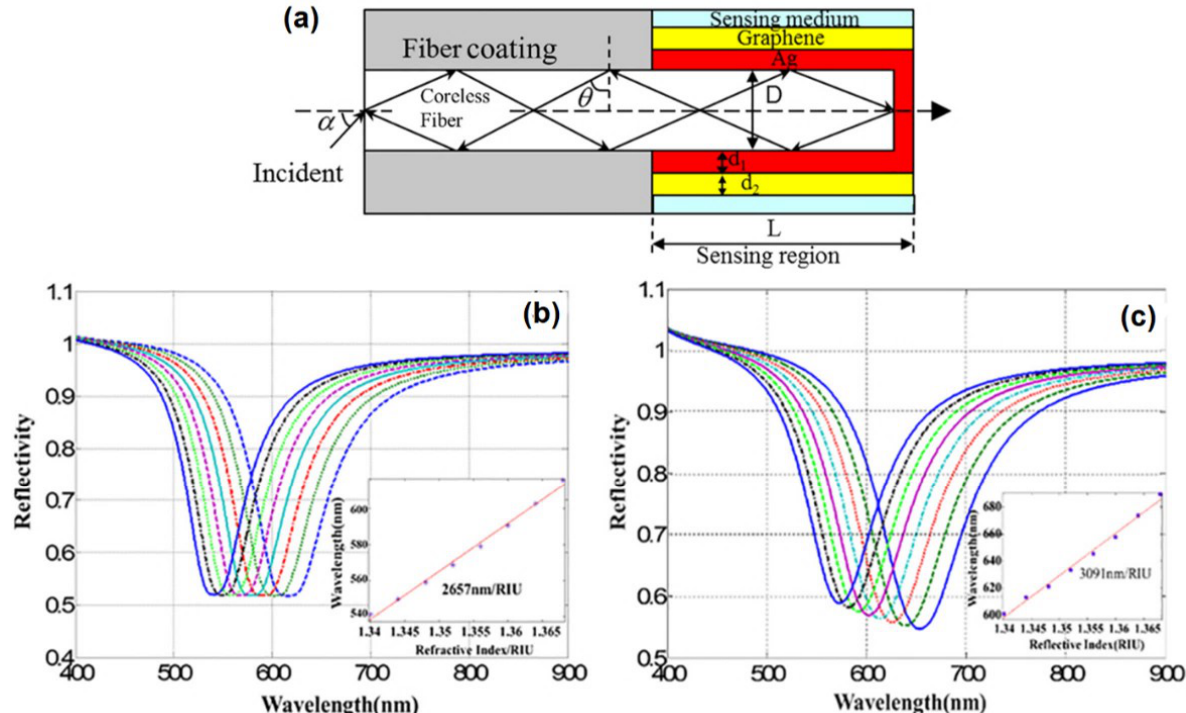
Figure 12. ( a ) Schematic diagram of an end reflection optical fiber with graphene. ( b ) SPR reflectance and sensitivity spectra were generated in structures without (left) and with graphene (right) (adapted with permission from Reference [58], copyright